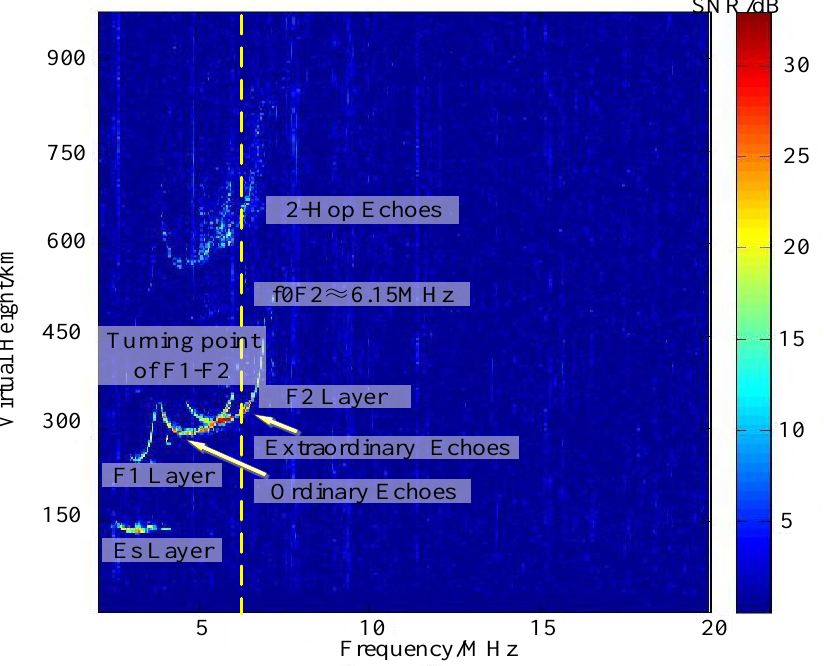
Figure 16. An example of vertical sounding ionogram at the local time of 17:50, 5 January 2018. For the ionogram, we use the quasi-parabolic segments (QPS) model to invert the electron density. In QPS model, the E, F1, and F2 layers are represented by a single quasi-parabolic (QP) model